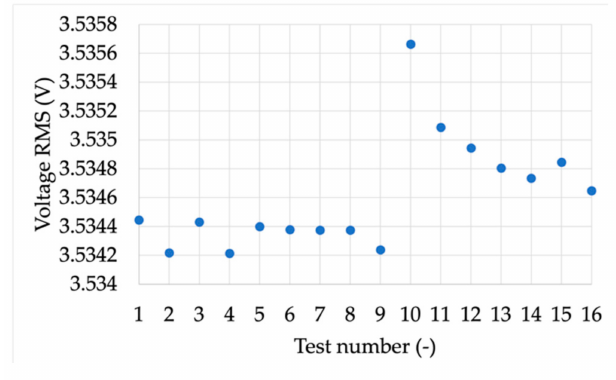
Figure 10. RMS for each harmonic test (Table 17).